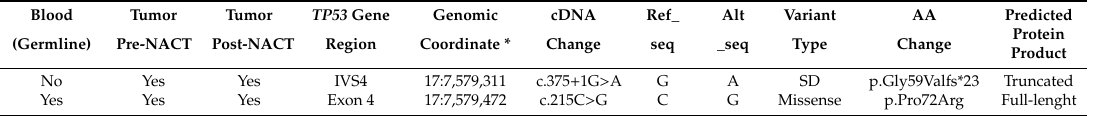
Table 1. TP53 SNVs identified by NGS in a patient with HGSOC treated with